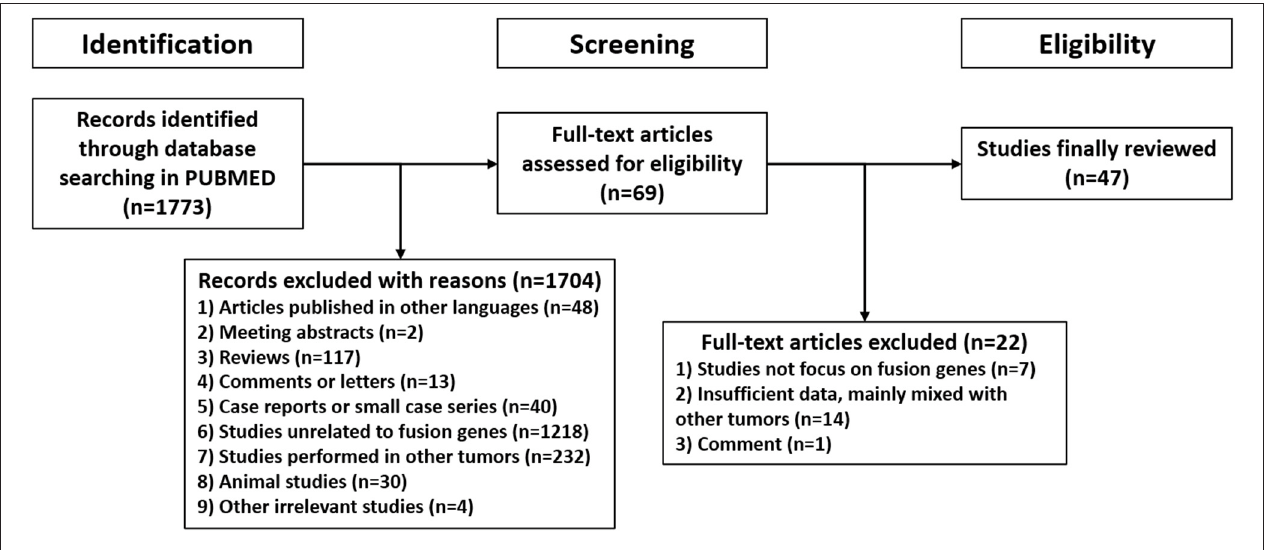
FIGURE 2 | Flow chart of the systematic